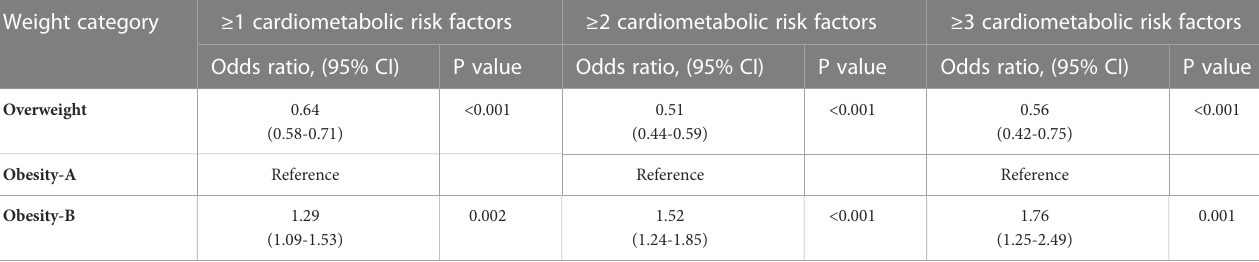
TABLE 5 Odds ratios of having ≥ 1, ≥ 2, and ≥ 3 (vs zero) cardiometabolic risk factors* by weight category in children and adolescents. Weight